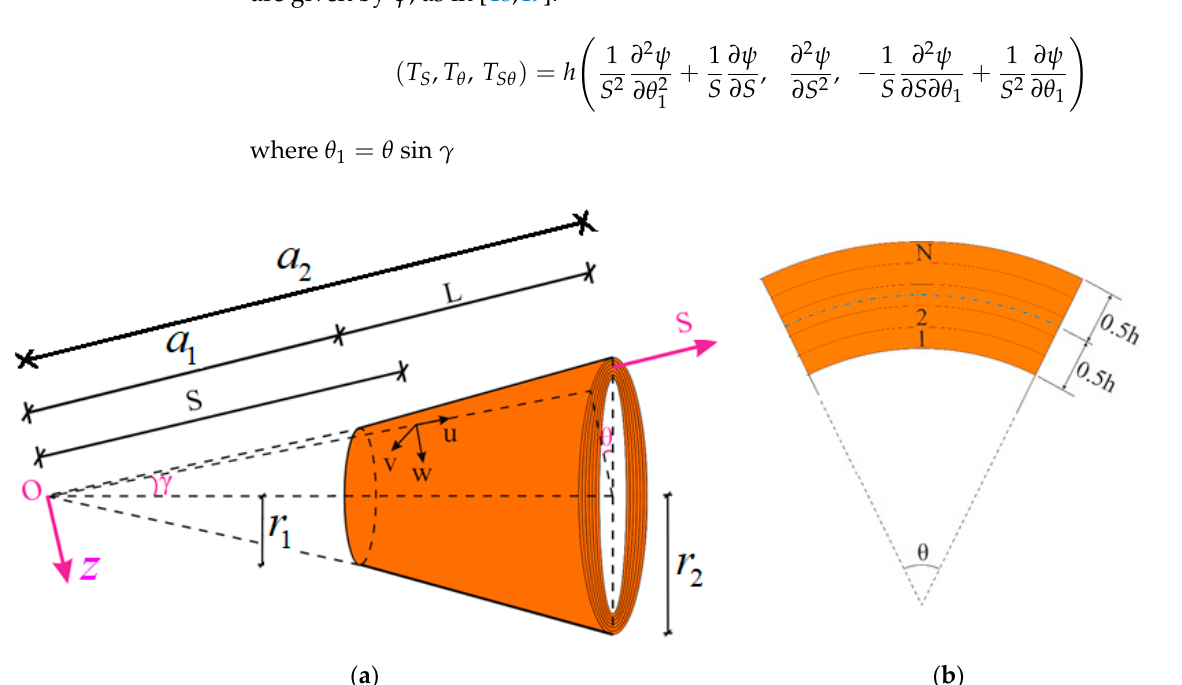
Figure 1. ( a ) Laminated truncated conical shell composed of CNT originating layers; ( b ) the cross section.